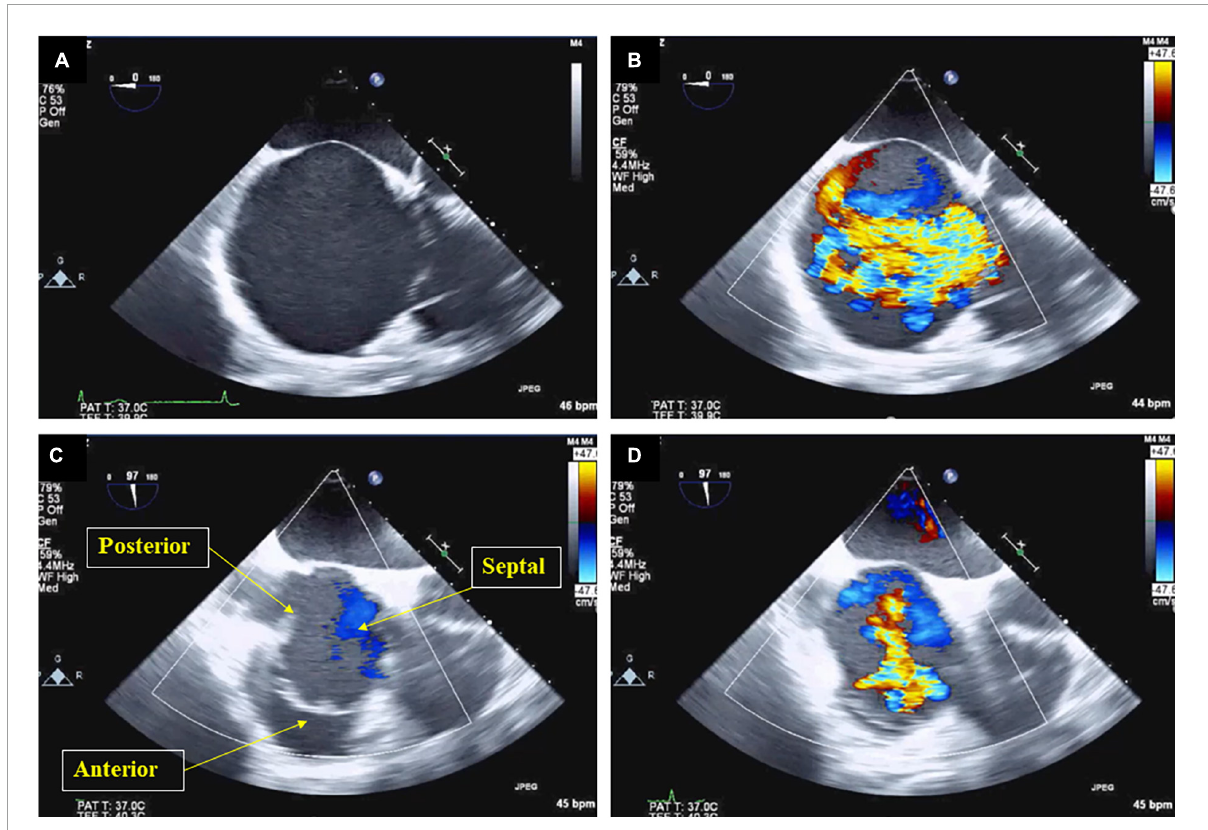
FIGURE2 Right atrium enlargement and severe tricuspid regurgitation in a trans-esophageal echocardiography. Trans-esophageal echocardiography shows spherical enlargement of the right atrium (A) , severe tricuspid regurgitation swirling in the right atrium was observed (B) . While the anterior, septal, and posterior leaflets were indicated when the tricuspid valve was open (C) , a regurgitation port was found between the anterior, septal and posterior leaflets, which was also a severe finding (D) .